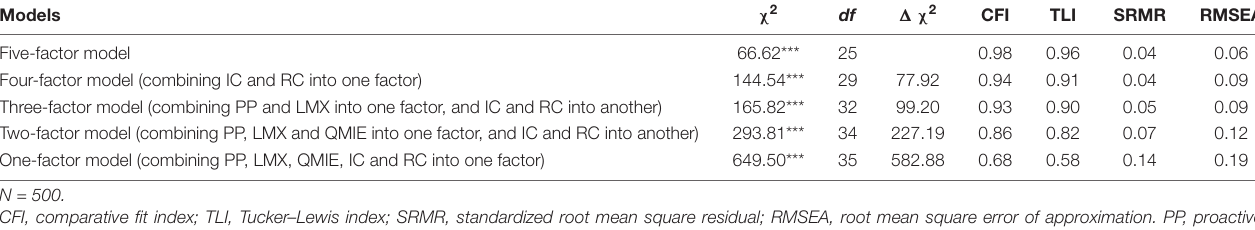
TABLE 2 | Comparison of measurement models.